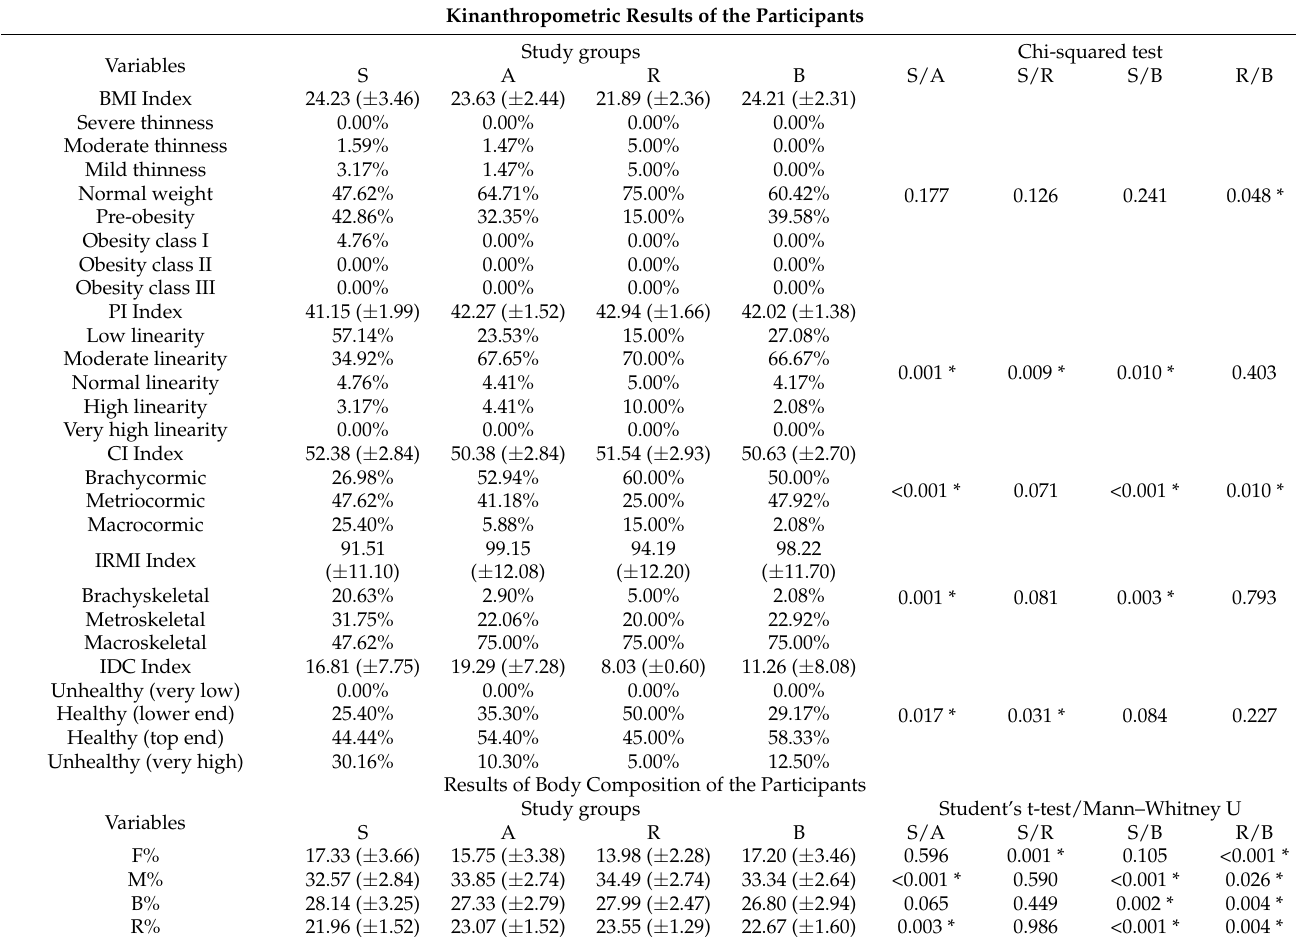
Table 3. Kinanthropometric and body composition results of the participants. S = persons without sport activity, A = persons with non-professional sports activity, R = runners, B = basketball players, S/A = contrast persons without sport activ- ity/persons with non-professional sports activity, S/R = contrast persons without sport activity/runners, S/B = contrast persons without sport activity/basketball players, R/B = contrast runners/basketball players, BMI = Body Mass Index, IP = Weight Index, CI = Cormic Index, IRMI = Relative Lower Limb Index, IDC = Body Density Index. F% = fat percentage, M% = muscle percentage, B% = bone tissue percentage, R% = residual percentage, * = statistically